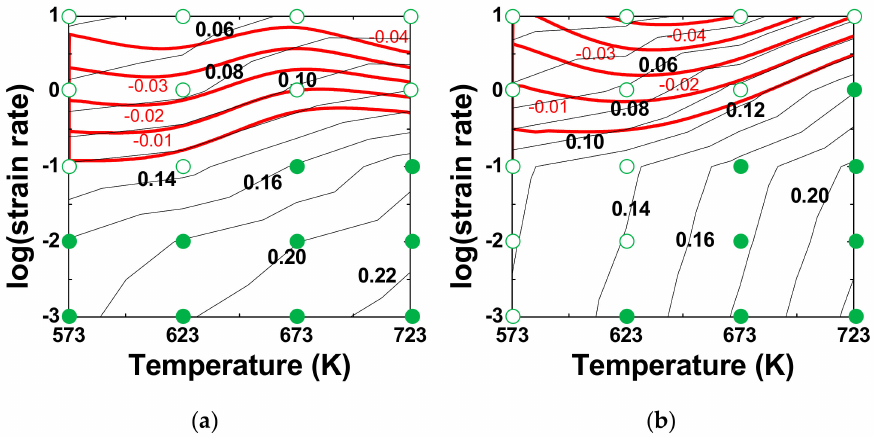
Figure 6. The m -maps of ( a ) the as-cast alloy and ( b ) the extruded alloy at ε = 0.6. The iso-e ffi ciency lines of ξ are superimposed on the maps. The black color contours and numbers represent the m values, while the reddish color contours and numbers represent the ξ values in the regime of flow instability. The open symbols represent the experimental conditions belonging to the PLB regime ( n 1 > 7), while solid symbols represent the experimental conditions belonging to the power-law creep regime ( n 1 ≤